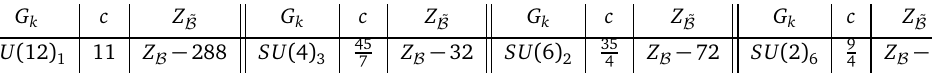
symmetry, a subgroup of 2 is given by a constant for each model. (cid:101) B